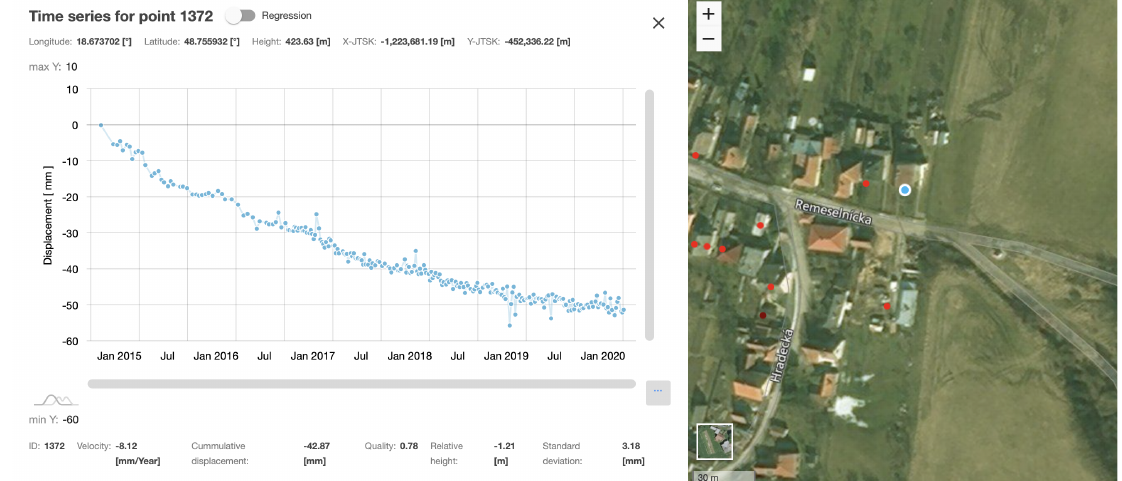
Figure 10. Example of remotIO PS point at Velka Lehotka village exhibiting deceleration of movement activity over past